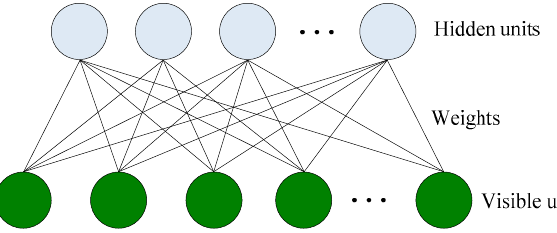
Figure 1. Architecture of Restricted Boltzmann Machines